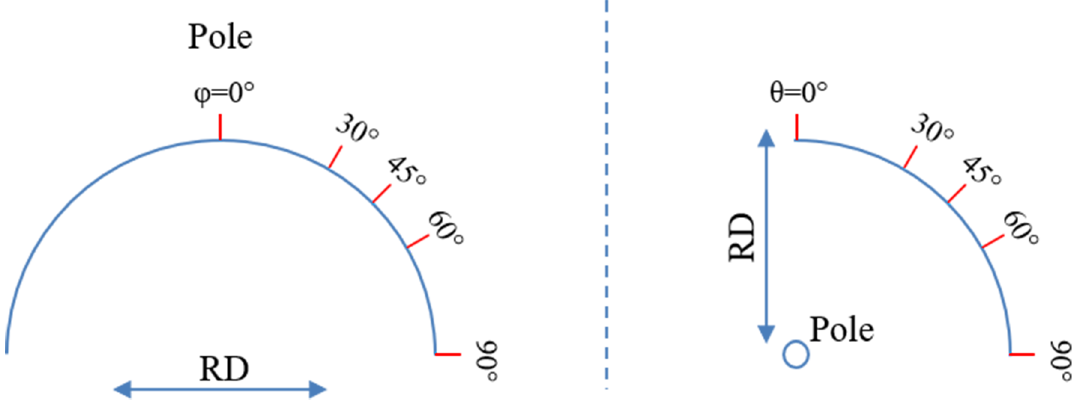
Figure 2. The coordinate system with two dimensions adopted in this work.